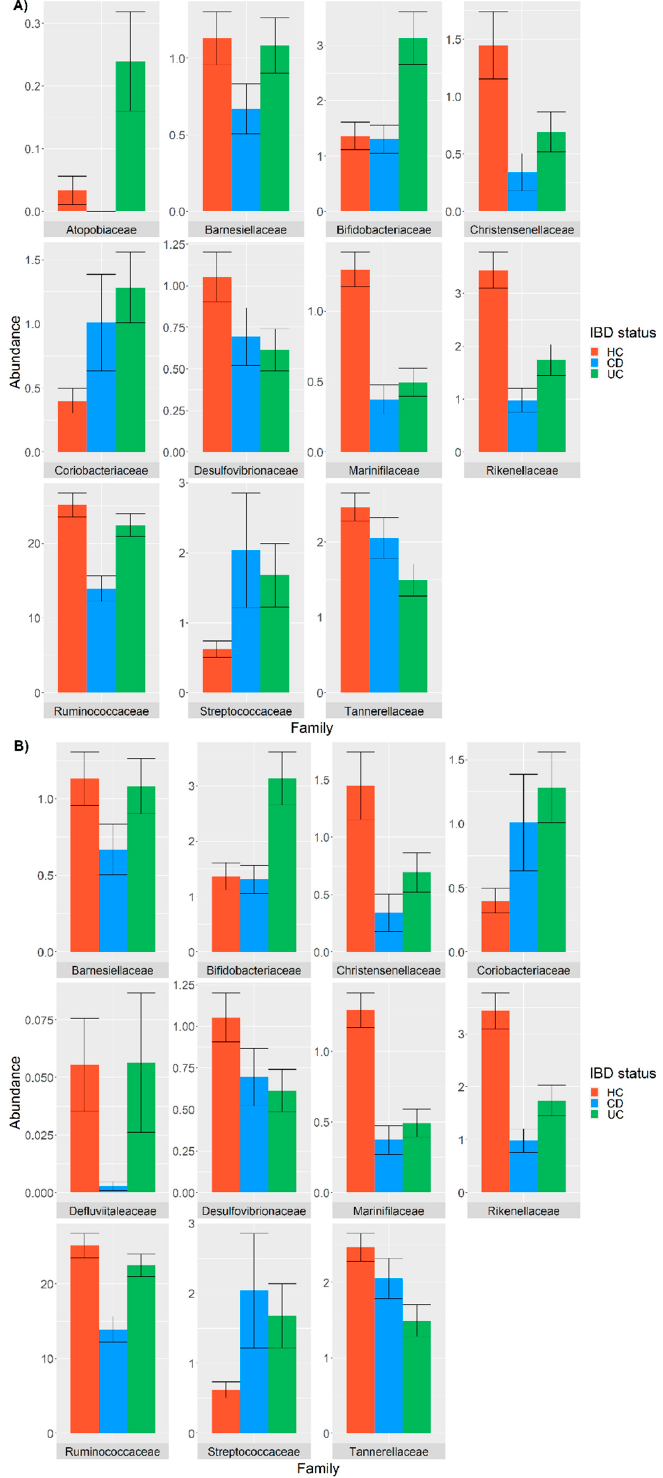
Figure 1. Differentially abundant bacterial families in samples from the CD (cyan) and UC patients (green) compared with the HC (pink), as detected using a GLM model only considering the IBD status ( A ) or using a GLM considering the IBD status and covariates and confounders ( B ). The relative abundance is plotted in log10 on the y